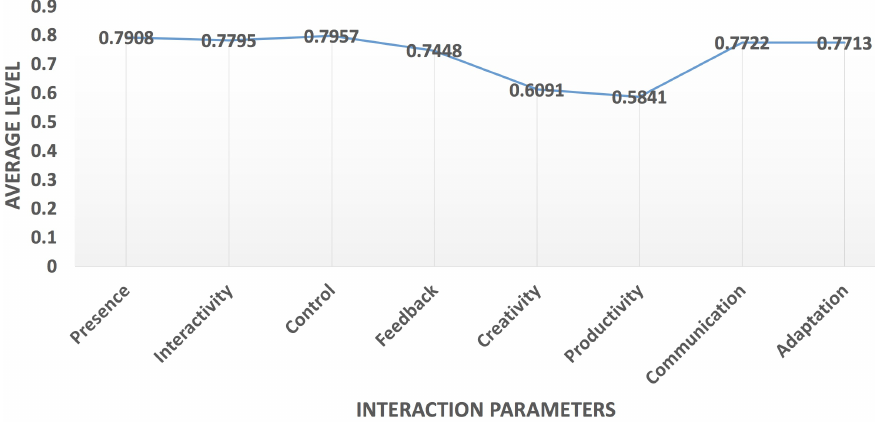
Figure 4. Average of Interaction